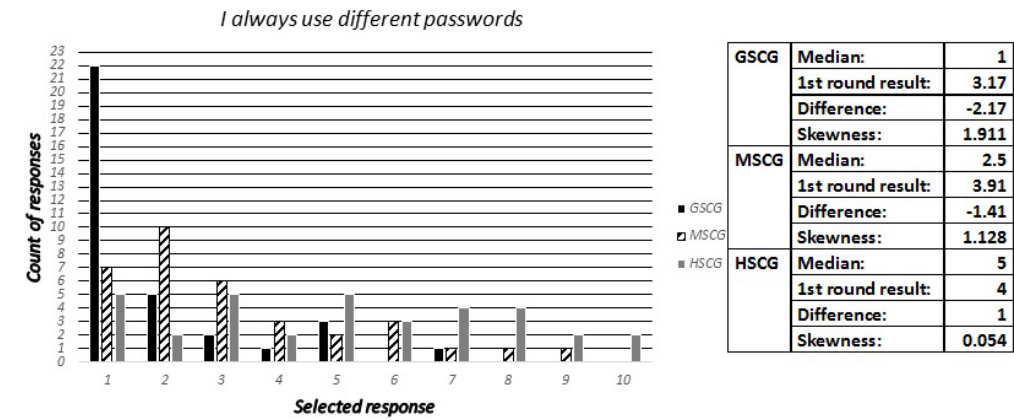
Figure 19. Expert predictions for question